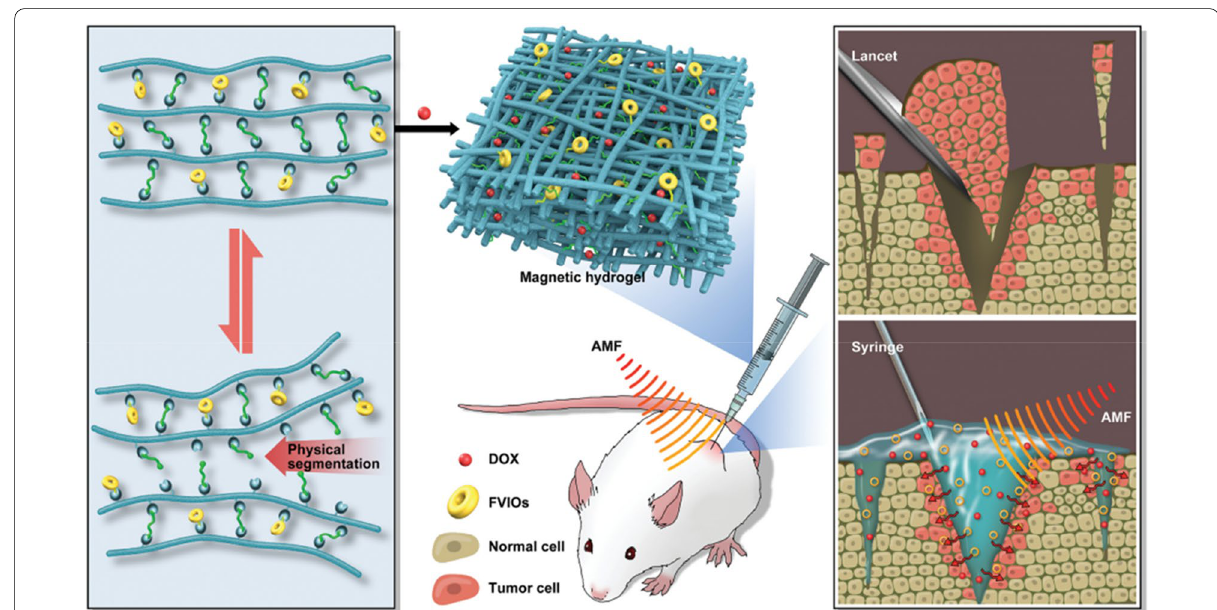
Fig. 1 Illustrates FVIO-functionalized magnetic hydrogel with optimal adaptive functions for breast cancer postoperative recurrence